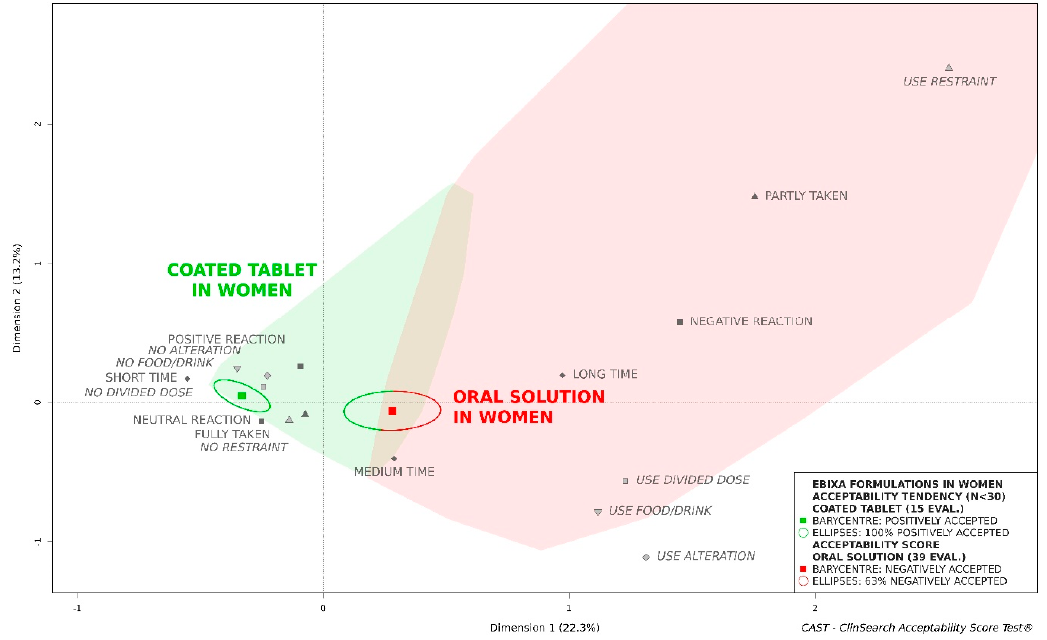
Figure 1. Acceptability of the original formulations of memantine (Ebixa ® ) in the older population.